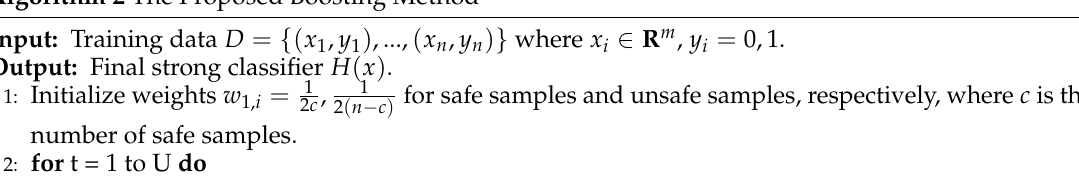
Algorithm 2 The Proposed Boosting